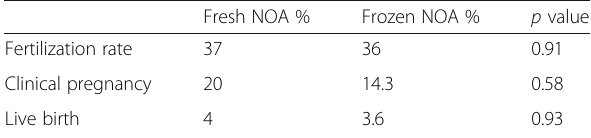
Table 4 Comparison of outcomes between fresh and frozen- thawed non-obstructive azoospermia group